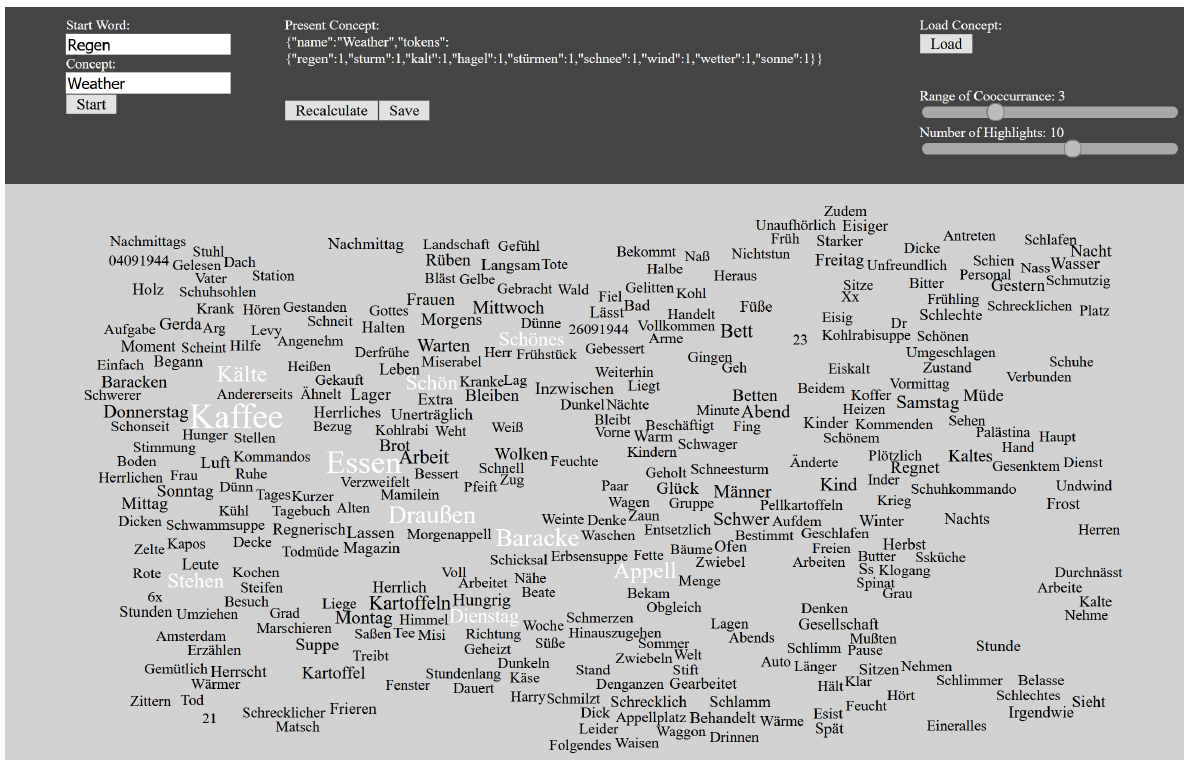
Figure 7. Adding more tokens to the concept results in a more populated suggestion tag cloud, which allows for iterative building of the concept.